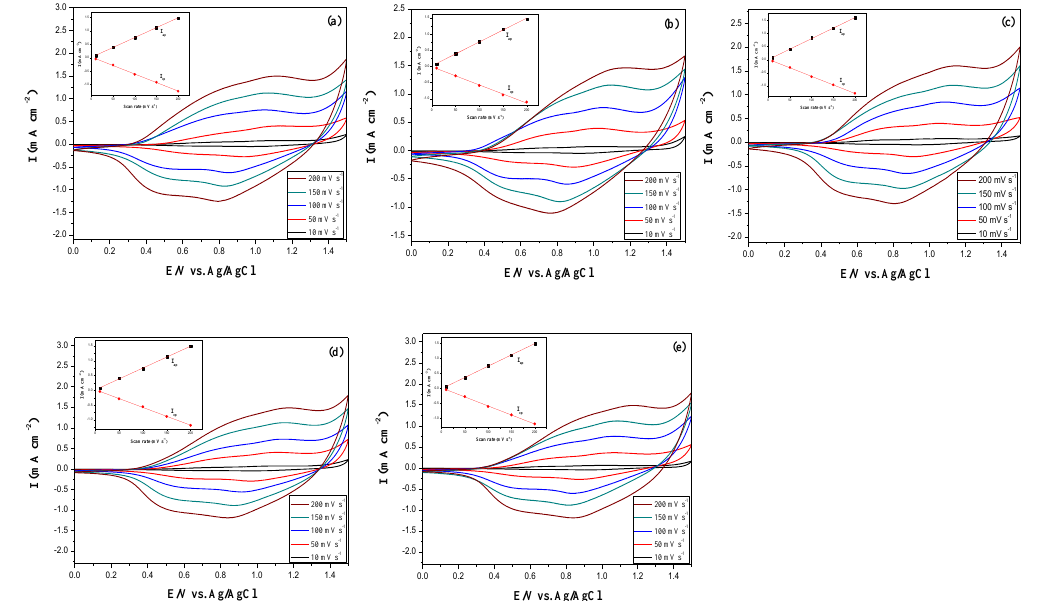
Figure 4. Cyclic voltammetry (CV) curves of ( a ) PDTC, ( b ) P(DTC- co -BTP), ( c ) P(DTC- co -BTP2), ( d ) P(DTC- co -TF), and ( e ) P(DTC- co -TF2) films at different scan rates between 10 and 200 mV s − 1 in the LiClO 4 + ACN solution. Inset: Plots of scan rate vs. anodic and cathodic peak current densities.